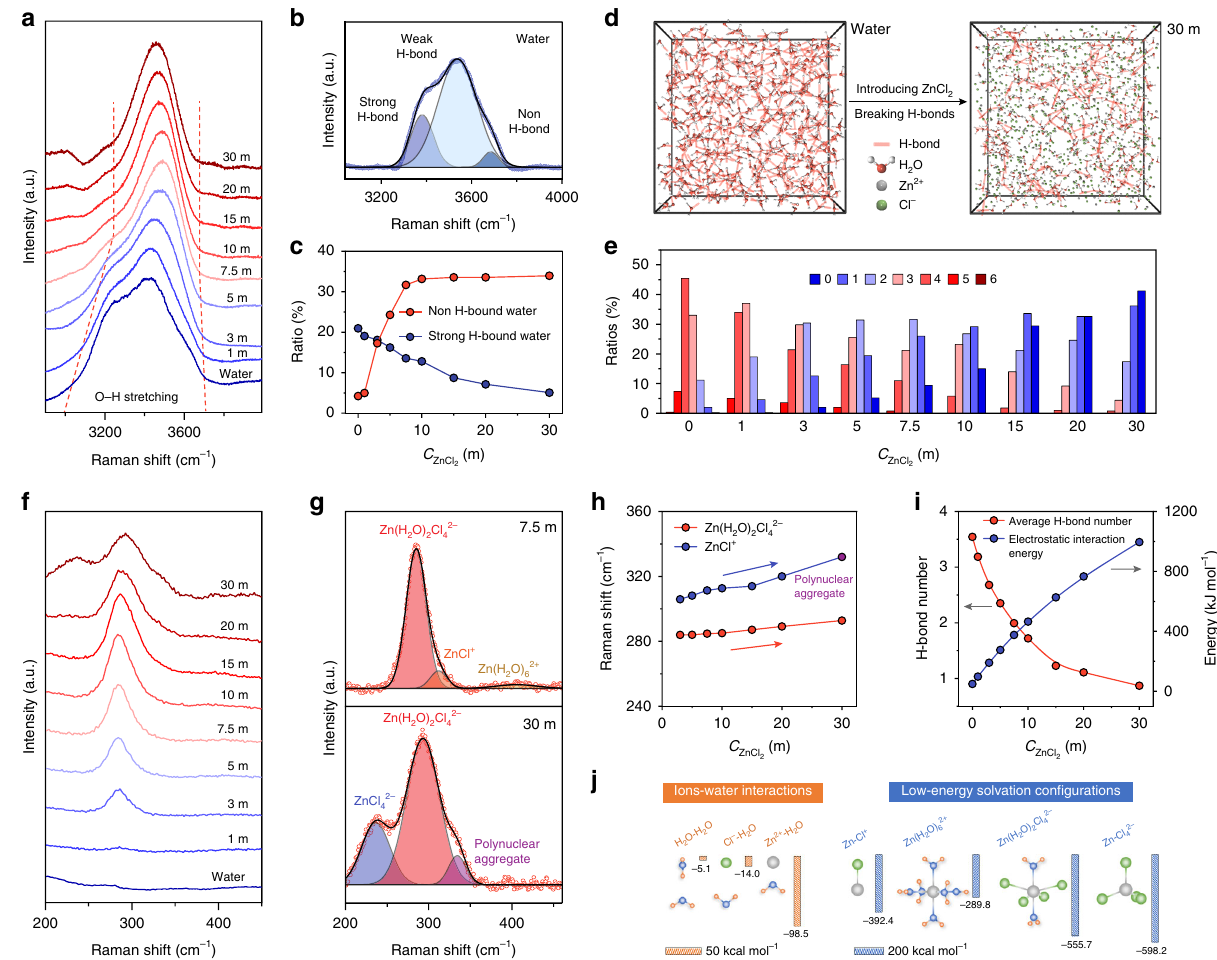
electrolyte. b The fi tted O – H 2